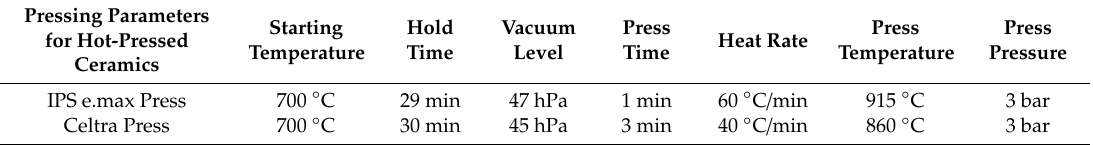
Table 4. Parameters for ceramics